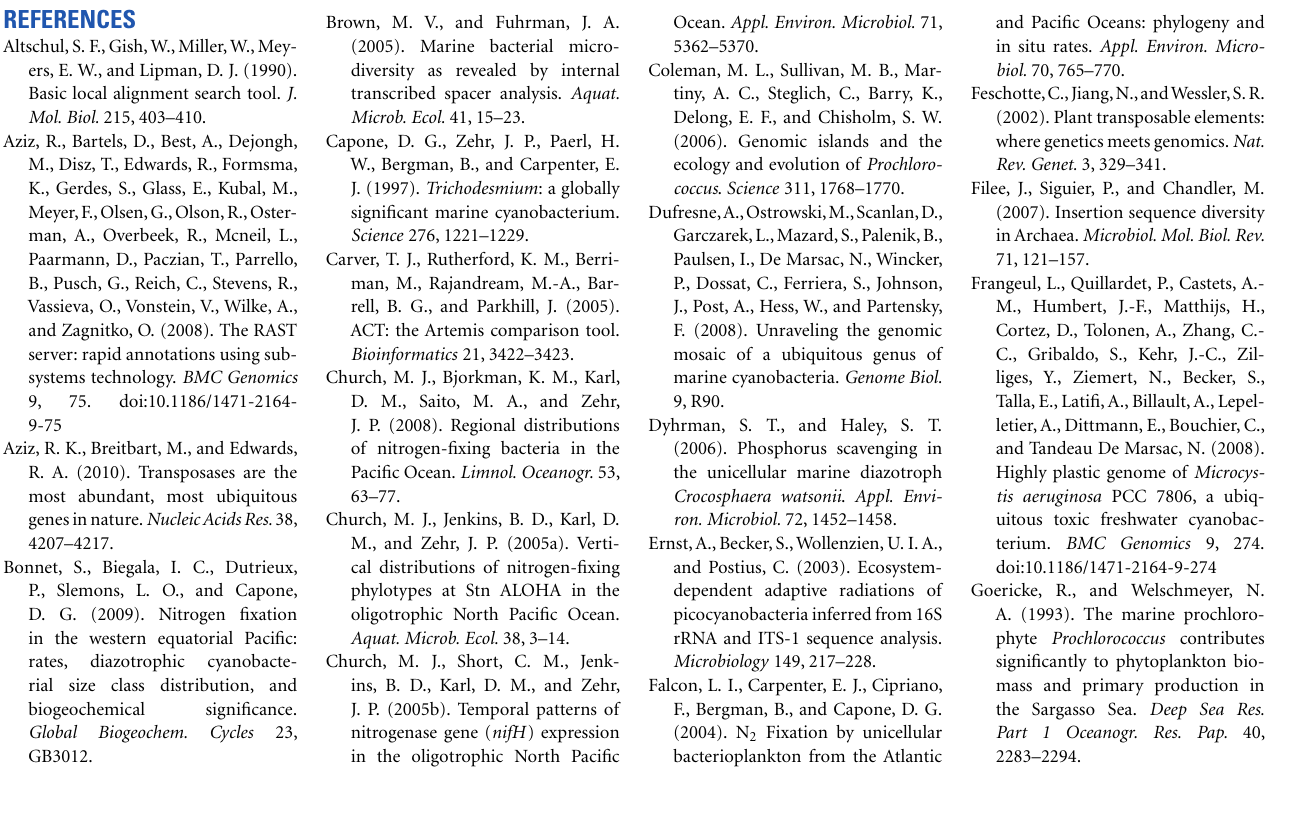
Table S1 | WH8501 Re-annotatedTransposase ORFs. Table S2 | WH8501Transposase Isoform Counts. Table S3 | WH8501 strain-specific ORFs. Table S4 | WH0003 strain-specific ORFs. Table S5 | WH0003 ORFs in longest strain-specific